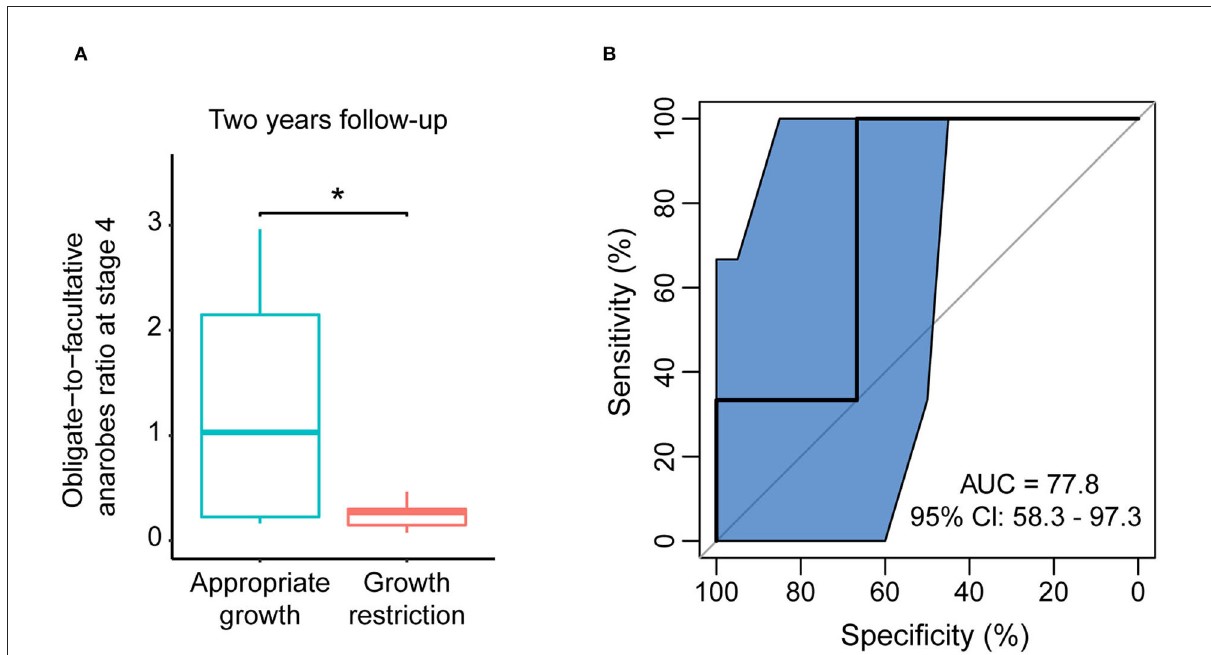
FIGURE3 The obligate-to-facultative anaerobes ratio at stage 4 was associated with long-term growth restriction. (A) The obligate-to-facultative anaerobes ratio at stage 4 in the non-EUGR and EUGR groups at 2-year follow-up. * p < 0.05 by Wilcoxon rank-sum test. (B) Using the obligate-to-facultative anaerobes ratio at stage 4 as an indicator to distinguish long-term growth restriction in the EUGR